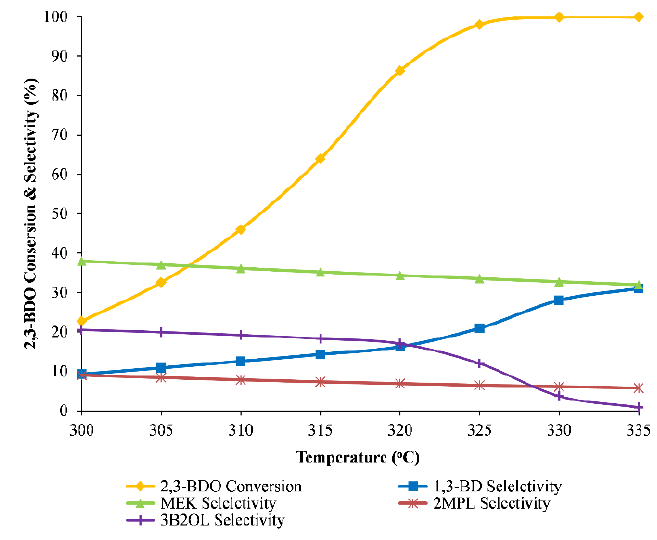
Figure 9. The influence of inlet temperature on reactor performance.